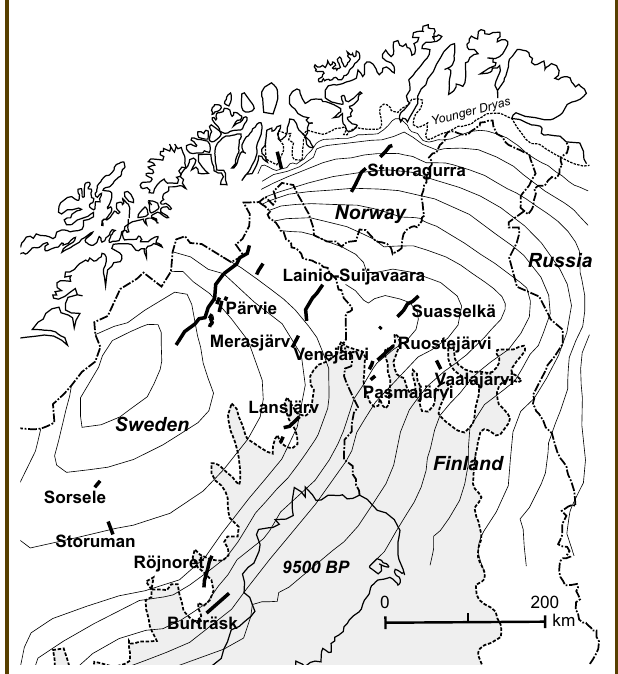
Figure 1. Location of PG faults in northern Fennoscandia (thick lines), and successive ice-marginal lines between ~10,000 years B.P. and 9,000 years B.P. (thin lines). The gray area shows the highest shoreline of the Baltic. Adopted from Kukkonen et al. (2010).